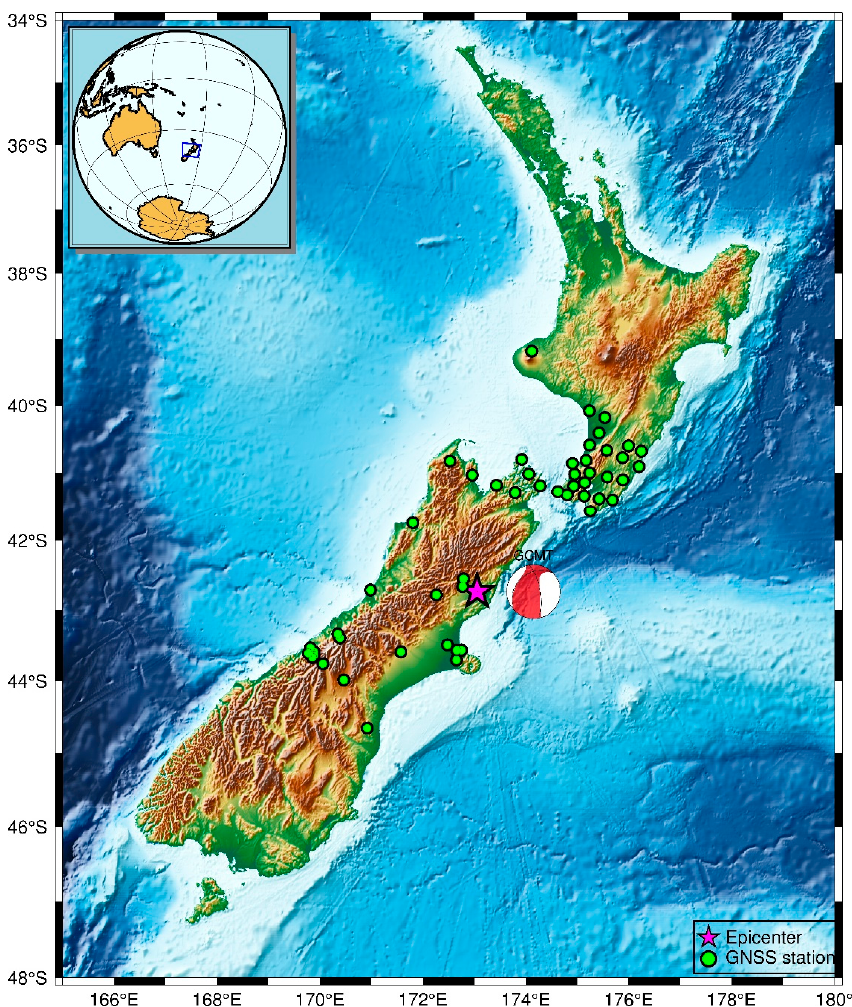
Figure 8. Location of the 2016 Kaik ō ura earthquake epicenter and the distribution of the selected 1 Hz GPS stations.